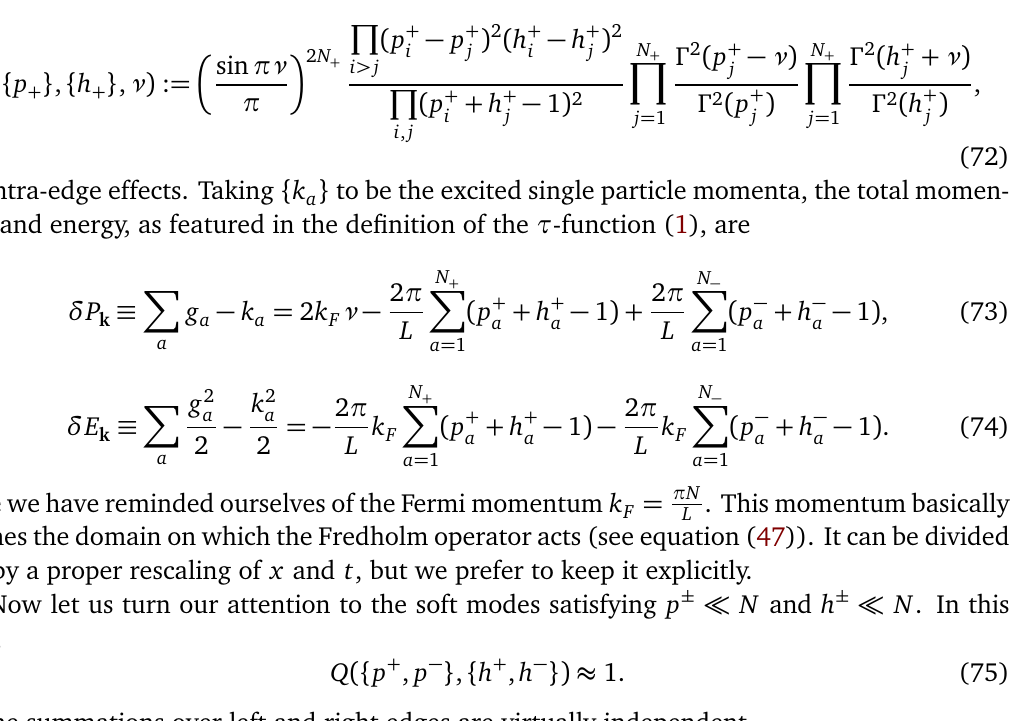
= 1. The left panel F = 50 k 2 , which means that for F F